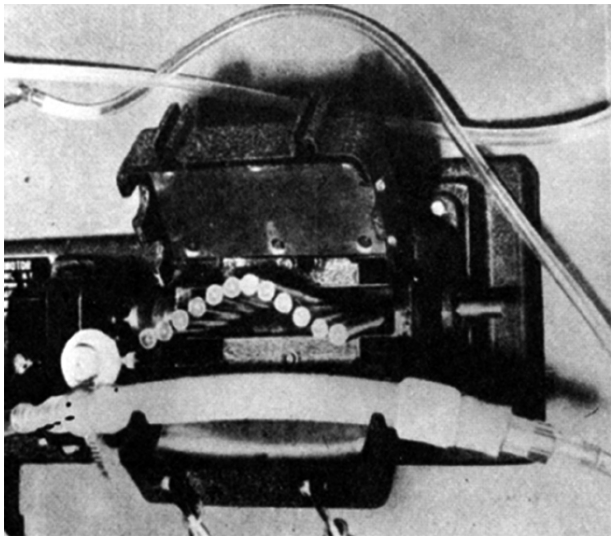
Fig.4 - Sigmamotor ® pump. Source: Correa Neto, 1988.